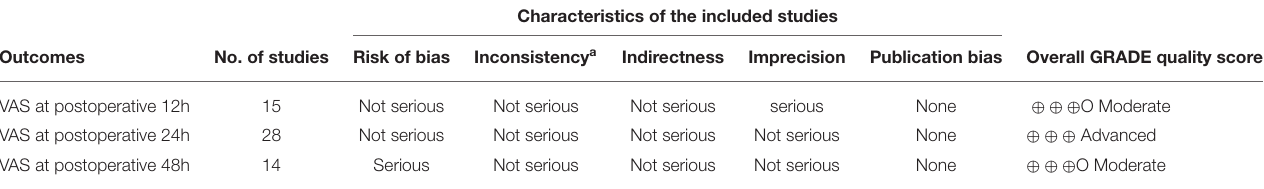
TABLE 4 | Quality of evidence according to the GRADE criteria.